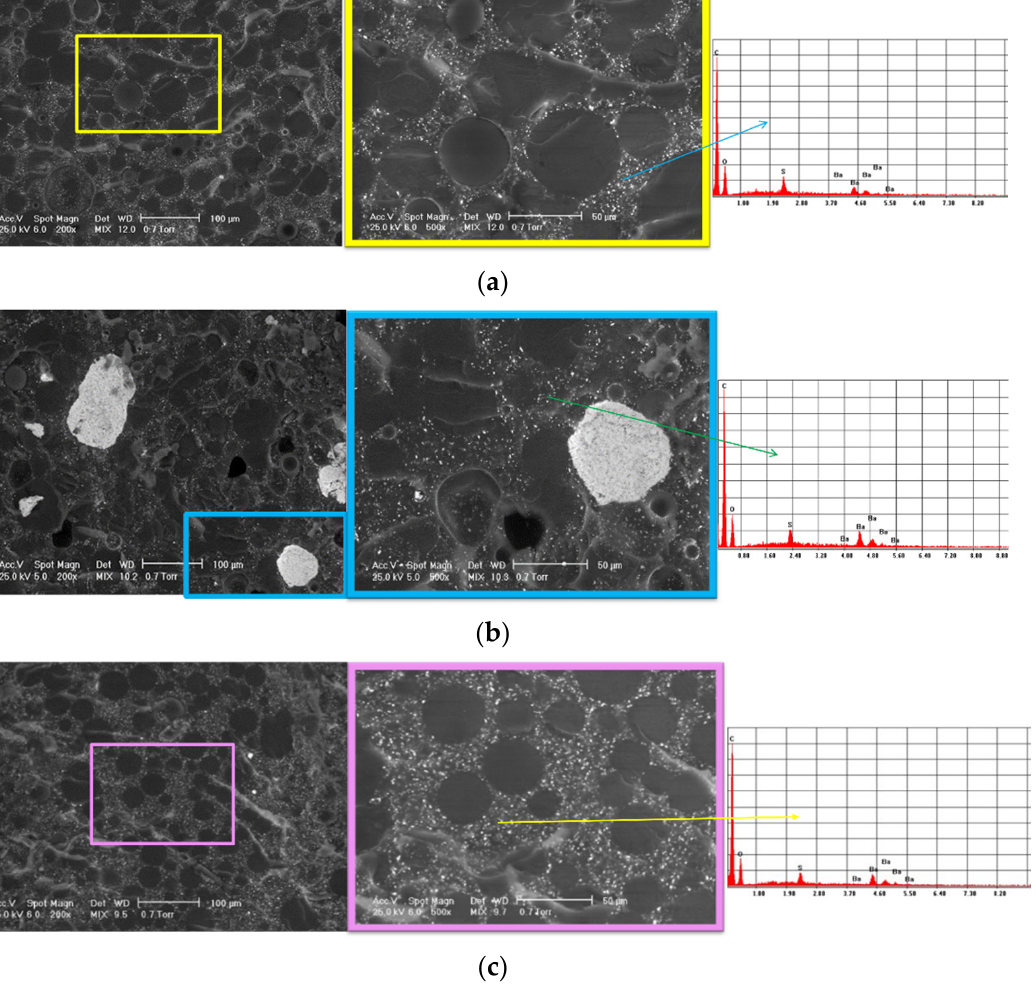
Figure 6. Representative SEM images and corresponding EDS spectra of the investigated samples: ( a ) sample 1; ( b ) sample 2; ( c ) sample 3.